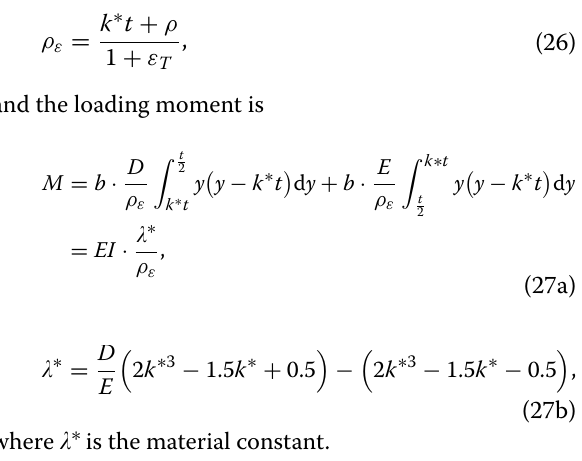
radius of the geometric center layer is ρ p . In addition to the basic assumptions (1) ‒ (5), it is also believed that any point in cross section does not produce plastic instabil- ity and reverse elastic–plastic deformation after stretch- bending deformation.